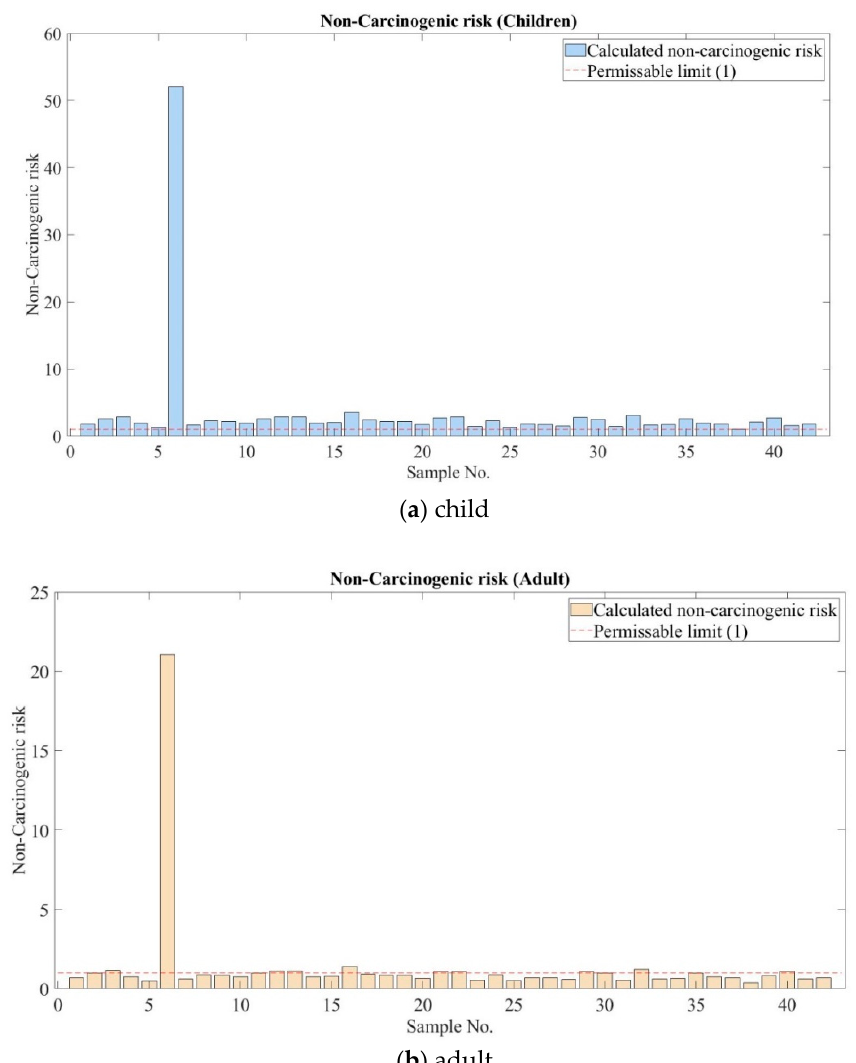
Figure 6. Hazard index (HI) for children and adults living in the ger area.